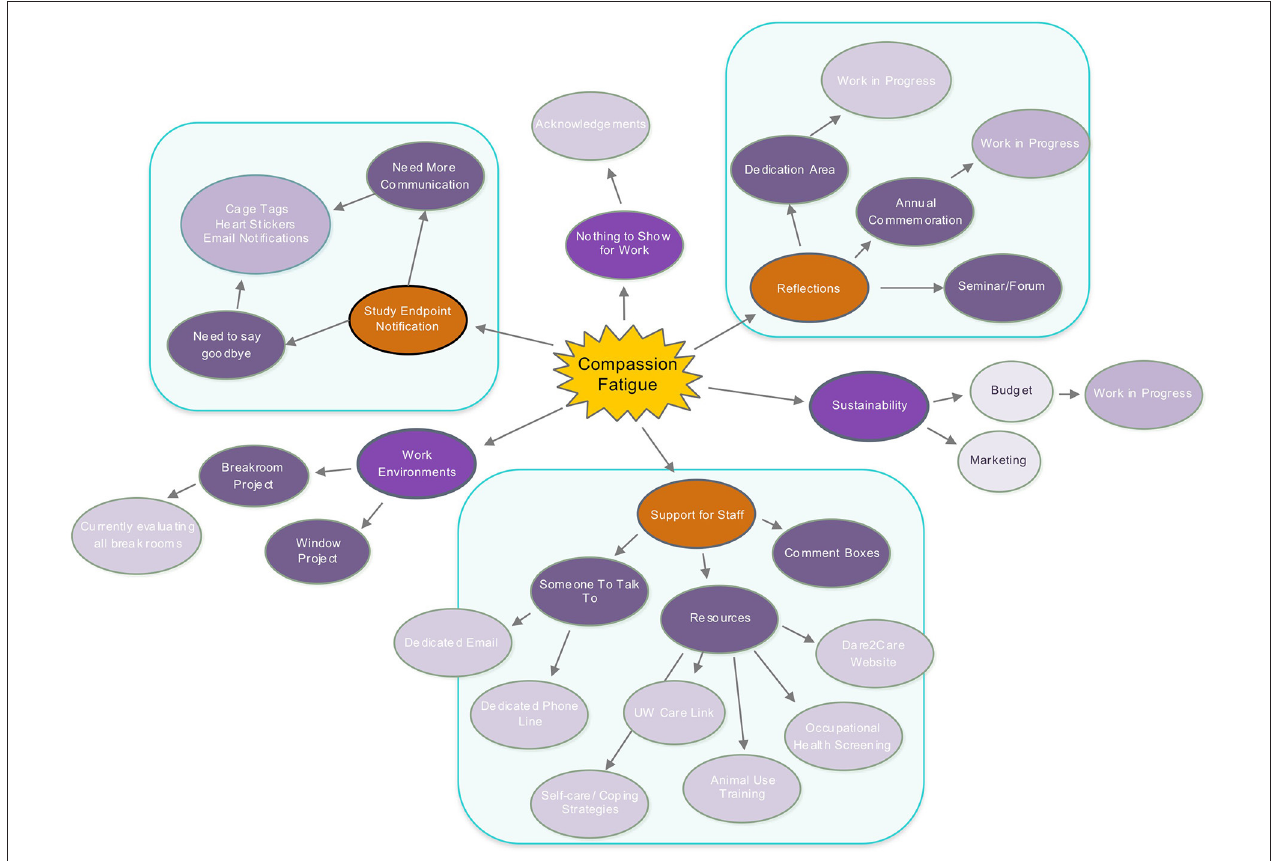
FIGURE 2 | Compassion fatigue at University of Washington